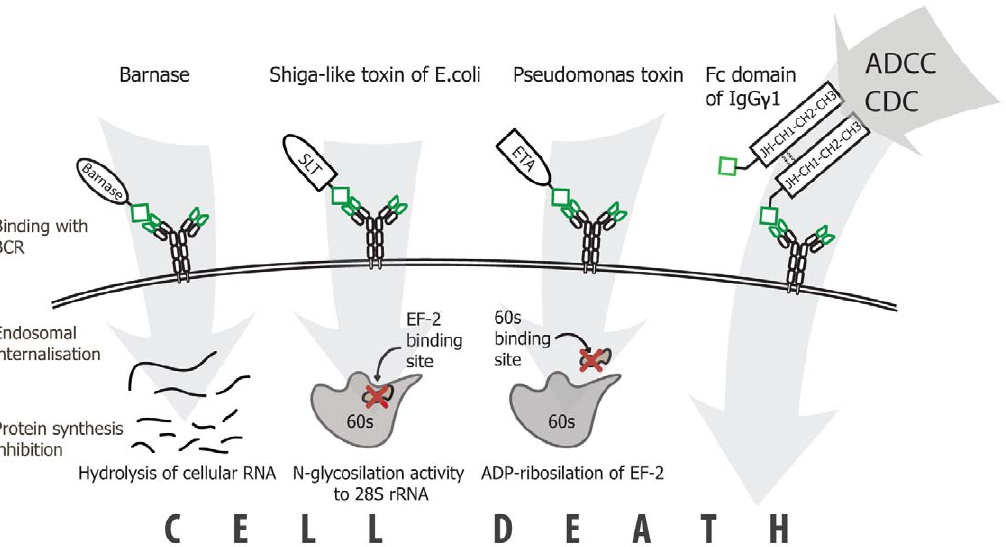
Figure 5. The mechanism of action of designed ITs. Barnase, Shiga-like toxin (SLT) and Pseudomonas toxin (ETA) are recognized by BCR due to the attached epitope with subsequent endosomal internalization followed by inhibition of protein synthesis via hydrolysis of cellular RNA, N- glycosylation of 28S rRNA or ADP-ribosylation of EF-2 respectively. In the case of Fc domain, targeted cell death occurs via antibody dependent cellular cytotoxicity (ADCC) or complement dependent cytotoxicity (CDC).